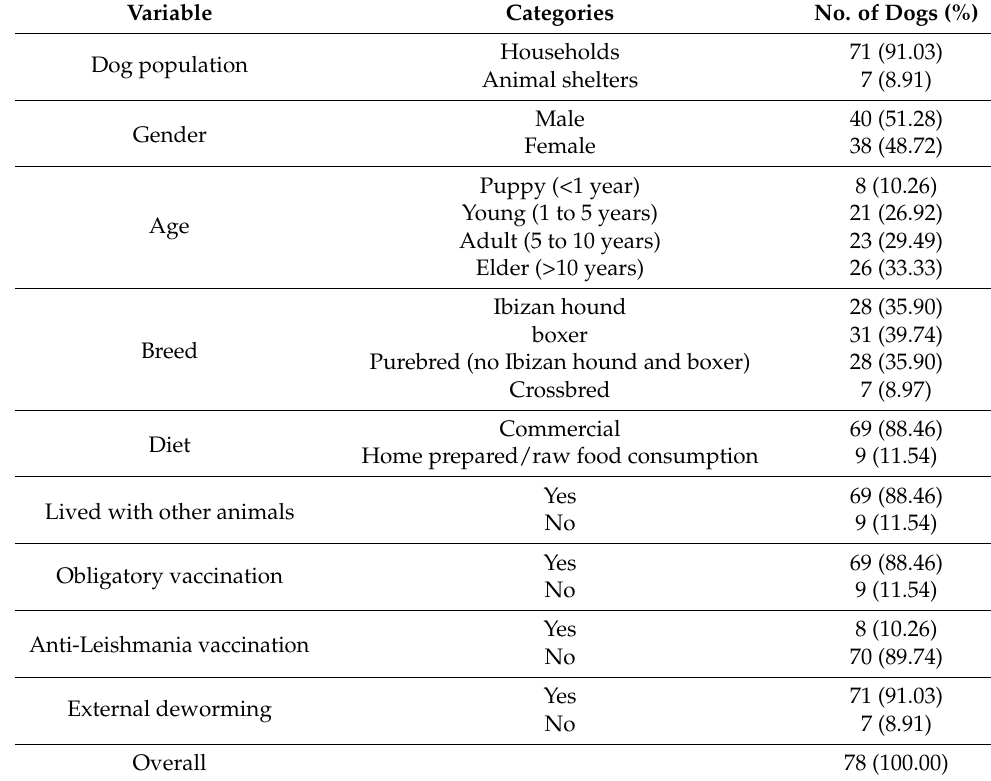
Table 1. Epidemiological data recovered of the animals studied.